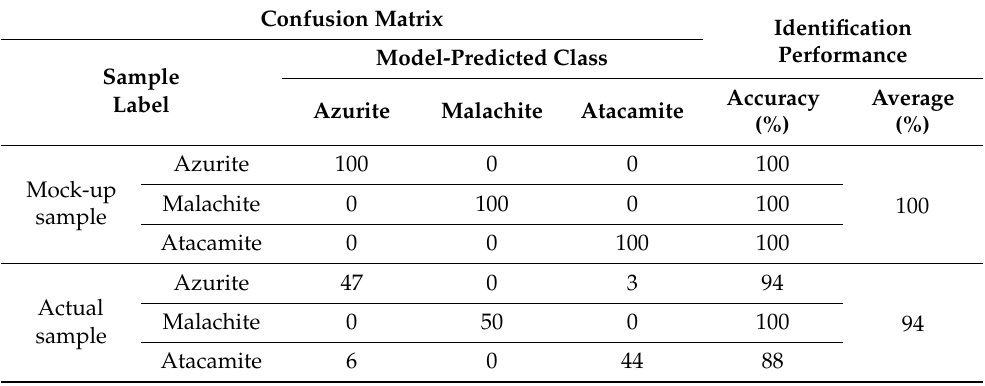
Table 5. Confusion matrix and accuracy of 2D-CNN identification model for three samples.